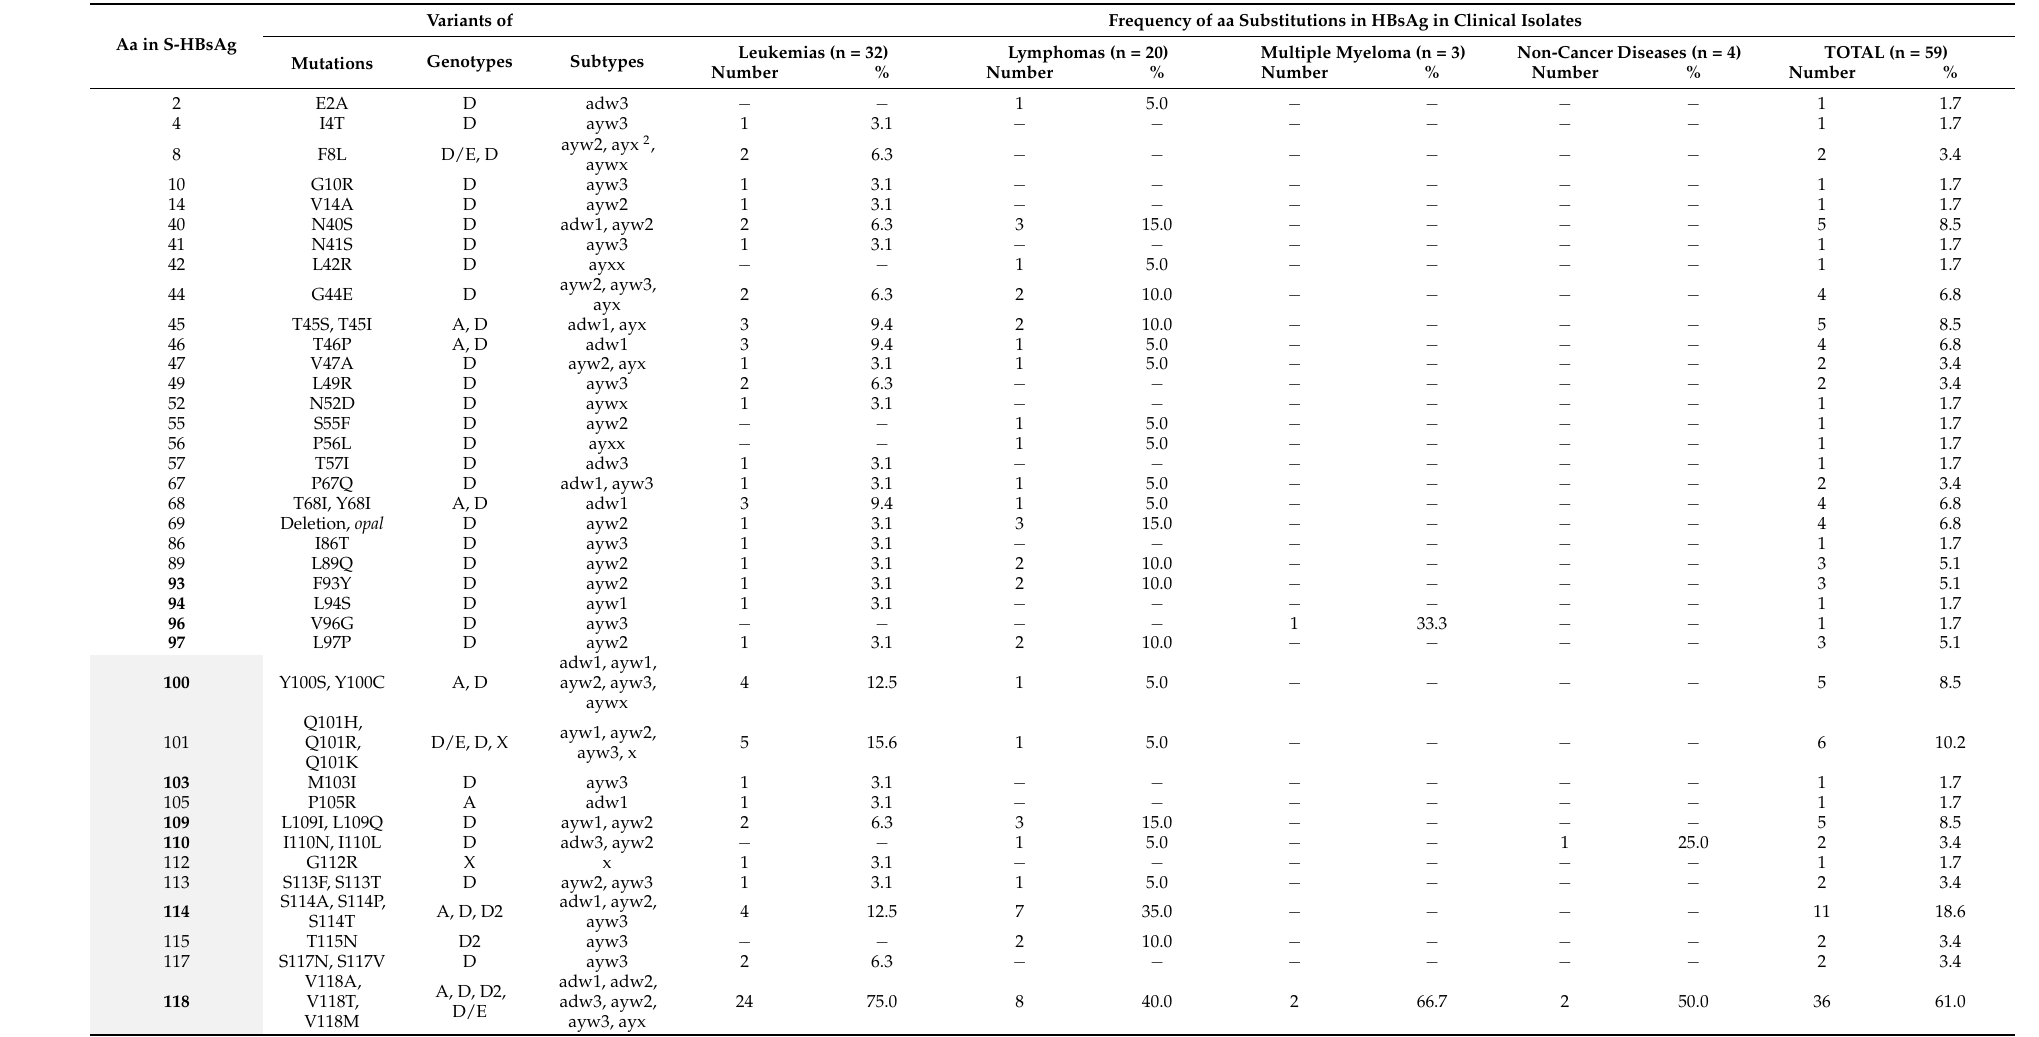
Table 4. Detailed characteristics of amino acid variations and their frequency in different groups of patients 1